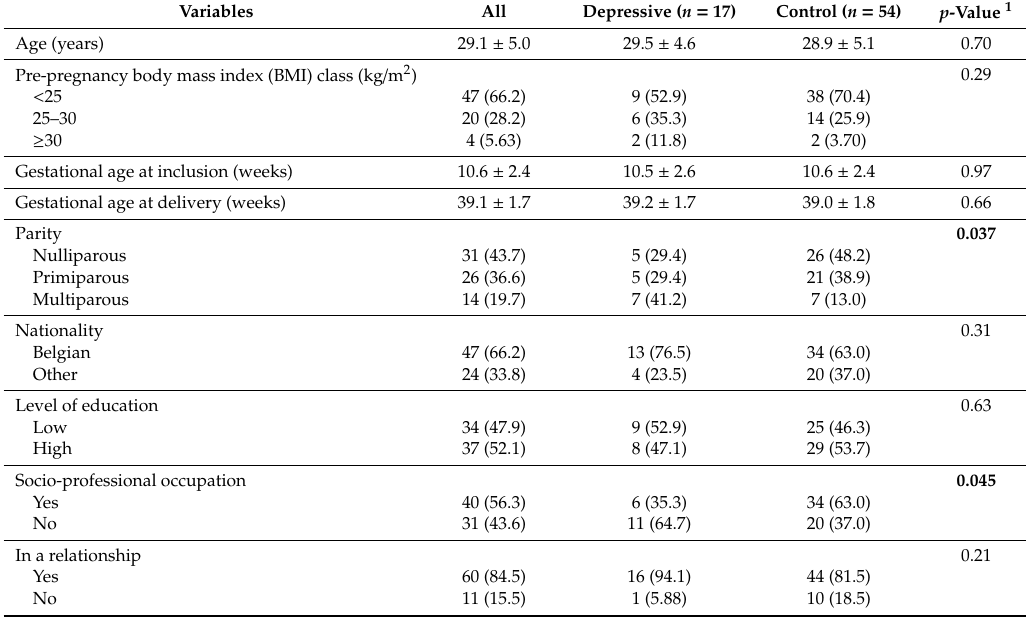
Table 1. Characteristics of the women ( n = 71).